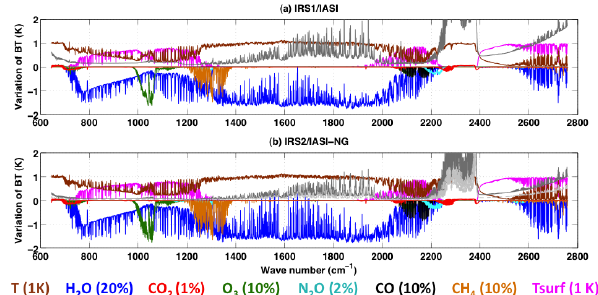
Figure 2. Sensitivities of infrared channels at the spectral resolution of IRS1/IASI (a) and IRS2/IASI-NG (b) to various atmospheric and surface variables and averaged over the whole tropical TIGR atmo- spheric situations. Variations of 1K of temperature (brown), 20% of water vapour (blue), 1% of CO 2 (red), 10% of O 3 (green), 2% of N 2 O (cyan), 10% of CO (black), 10% of CH 4 (orange) and 1K of surface temperature (pink). Also shown is the radiometric noise of each scenario computed at the BT of the channels (grey): IASI noise in (a) and IASI noise divided by 2 (dark grey in b ) and by 4 (light grey in b ). The computation of channels sensitivities is based on simulations performed using the forward radiative transfer model 4A/OP (Scott and Chédin, 1981; http://4aop.noveltis.com/) based on the GEISA09 spectroscopic database (Jacquinet-Husson et al.,